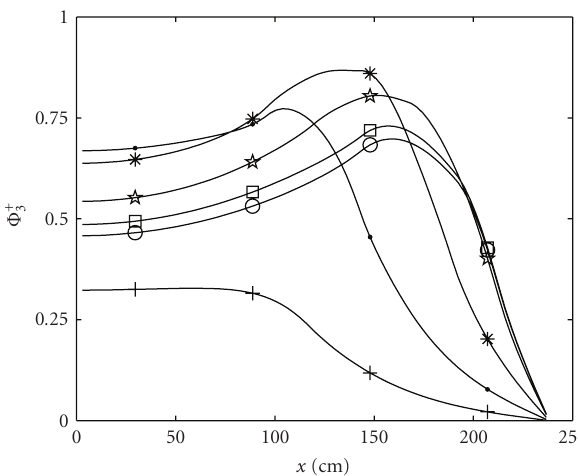
Figure 9: Graphs of the neutron importance for the third